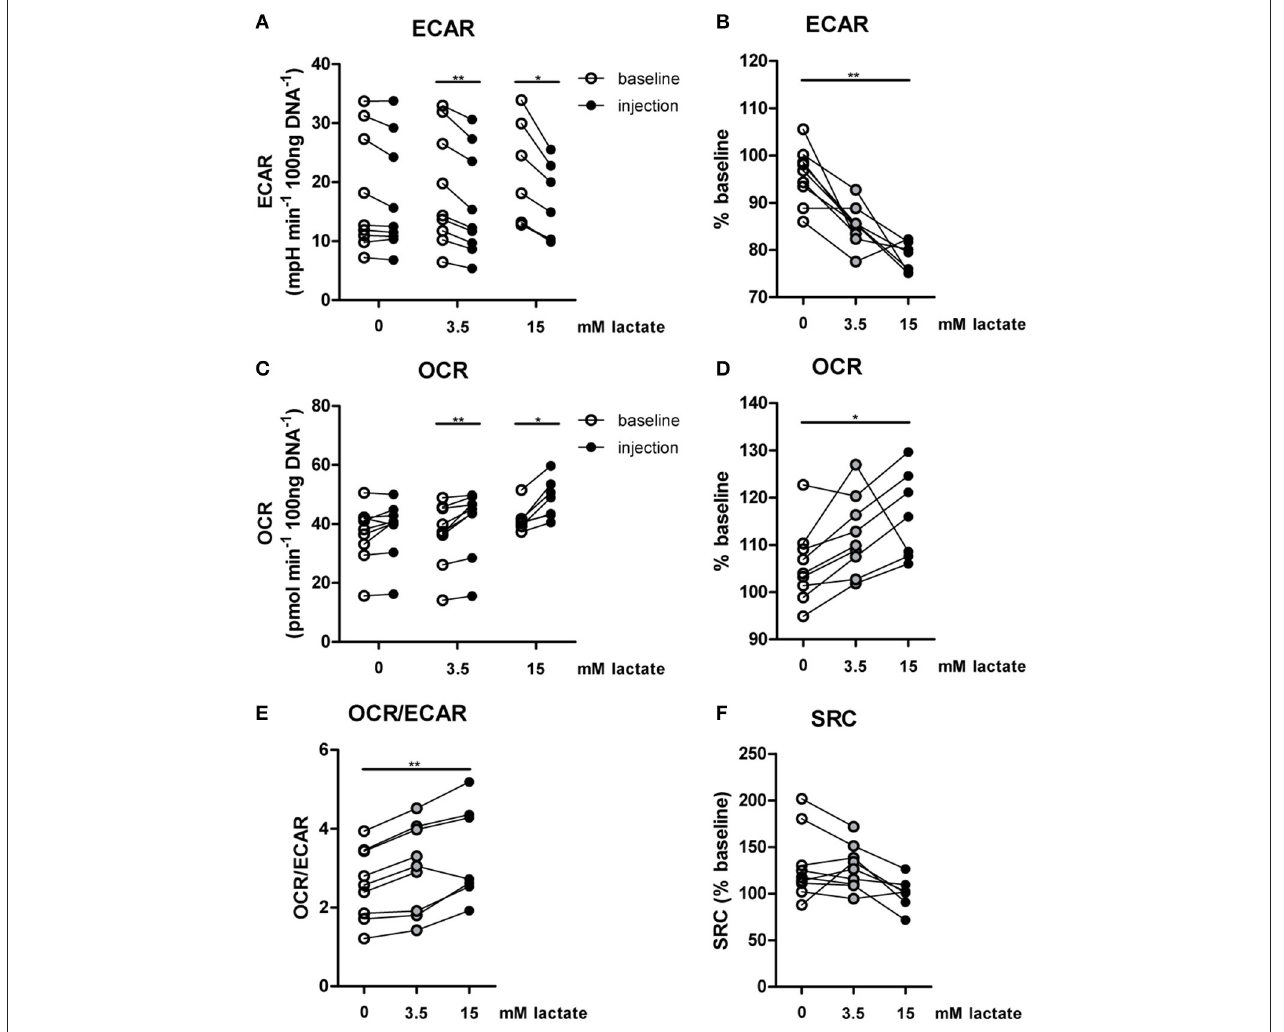
FIGURE 2 | In vitro , lactate acutely shifts metabolism of human monocytes to oxidative phosphorylation. (A–D) Change of ECAR (A,B) and OCR (C,D) in human CD14 + monocytes after exposure to lactate, presented as raw data or % baseline (before lactate injection). (E) OCR/ECAR after lactate injection. (F) Spare respiratory capacity (SRC) after lactate injection. Each dot represents one healthy individual. n = 7–9, * p < 0.05, ** p < 0.01, Wilcoxon signed rank test (A,C) , Friedman test with post-hoc Dunn’s test (B,D–F) .